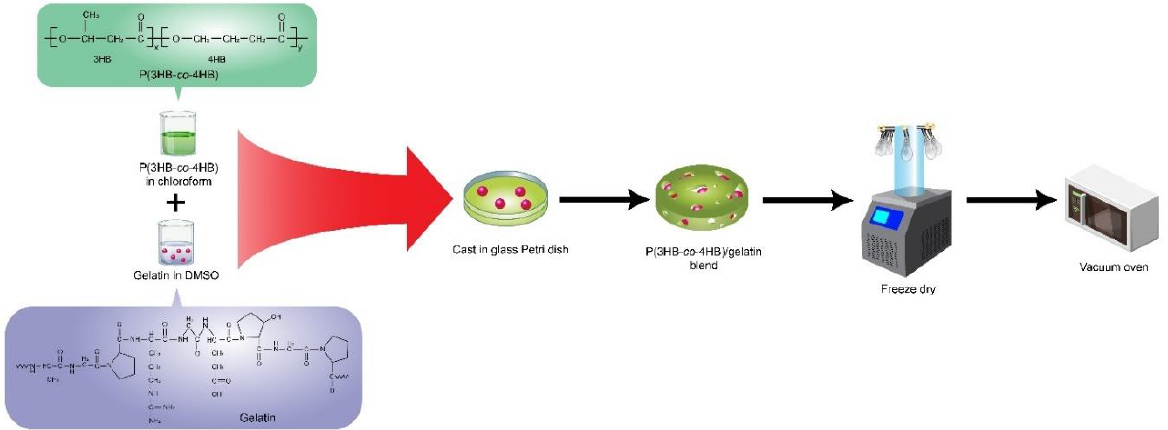
Figure 1. Schematic representation of the fabrication of P(3HB- co -4HB)/gelatine blend scaffolds which was prepared by solvent casting the mixture of fish gelatine and P(3HB- co -4HB) followed by freeze drying the scaffolds.